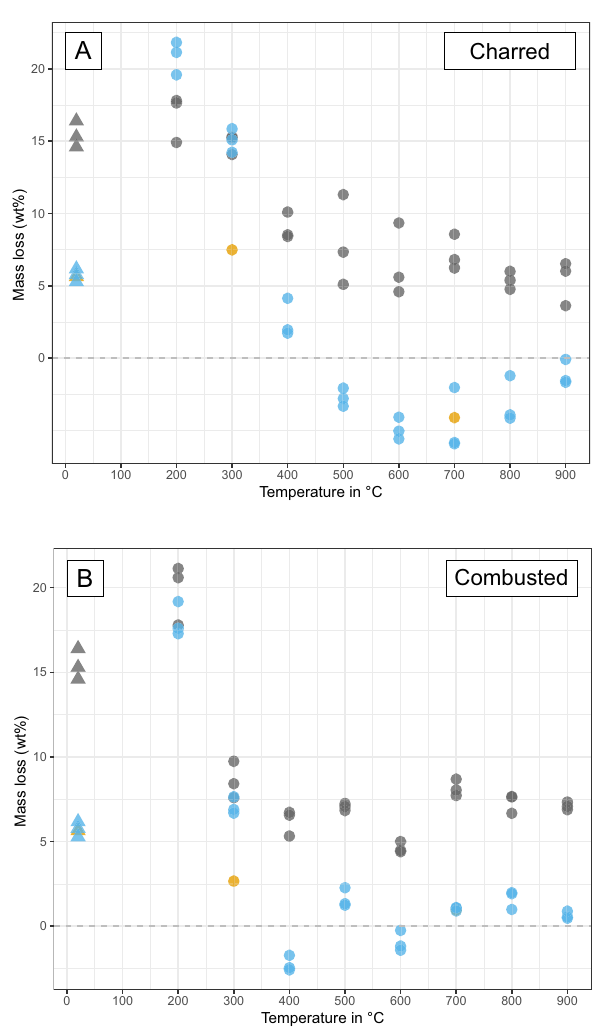
Figure 2. Graphs showing the mass loss (wt%) as a result of pH exposure for charred bone ( A ) and combusted bone ( B ). Triangles = unheated bone, circles = heated bone, grey = pH 3 samples, yellow = pH 7 samples, blue = pH 12 samples, dashed horizontal line = zero mass